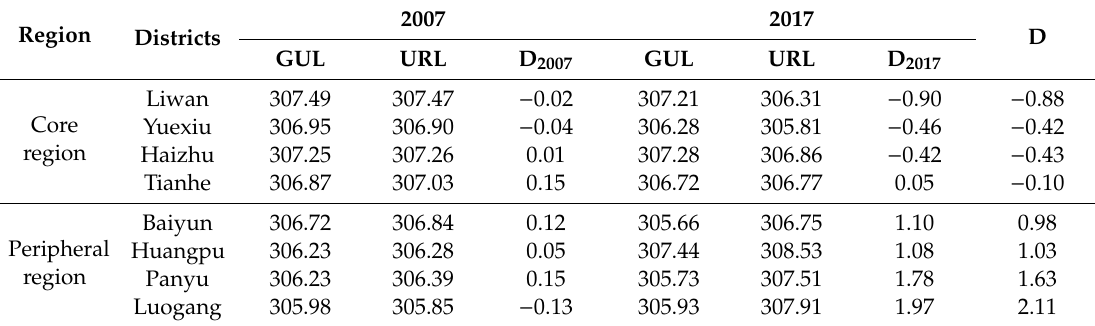
Table 3. Land surface temperature (LST, units of Kelvin) difference of GUL and URL in different regions from 2007–2017.